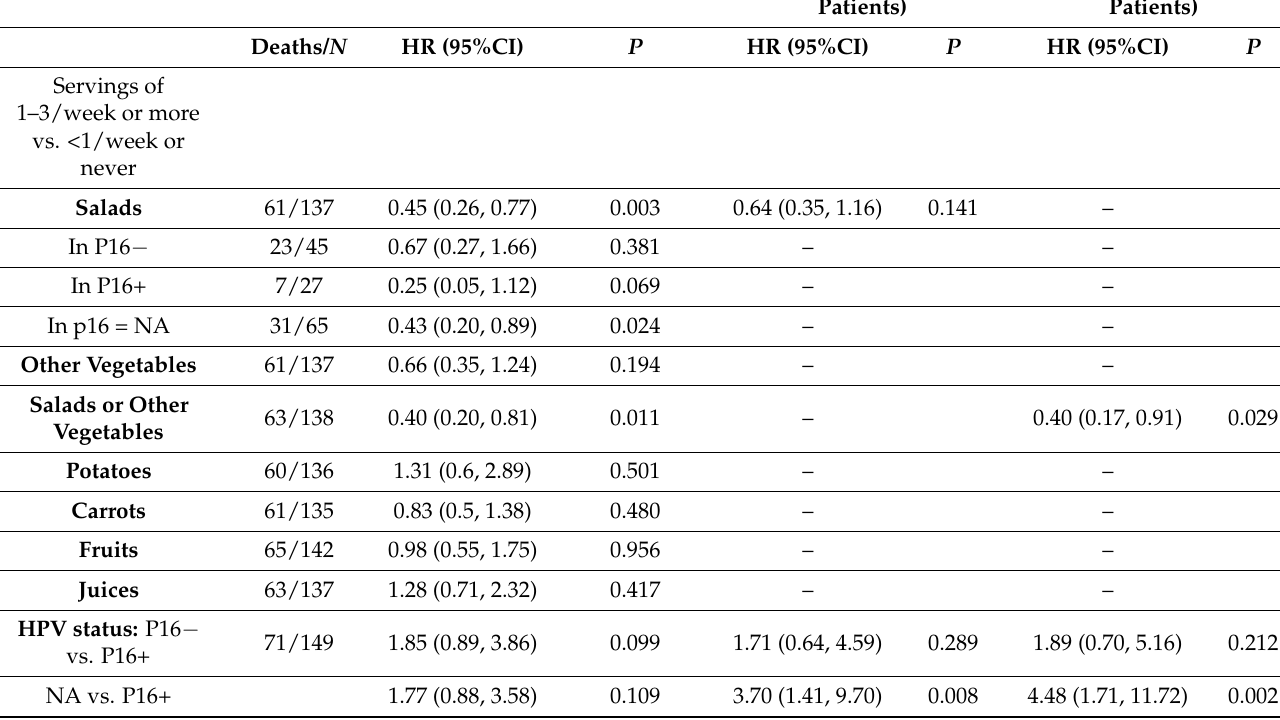
Table 3. Univariable and multivariable Cox regression models for overall survival: Effects of nutritional and other variables.